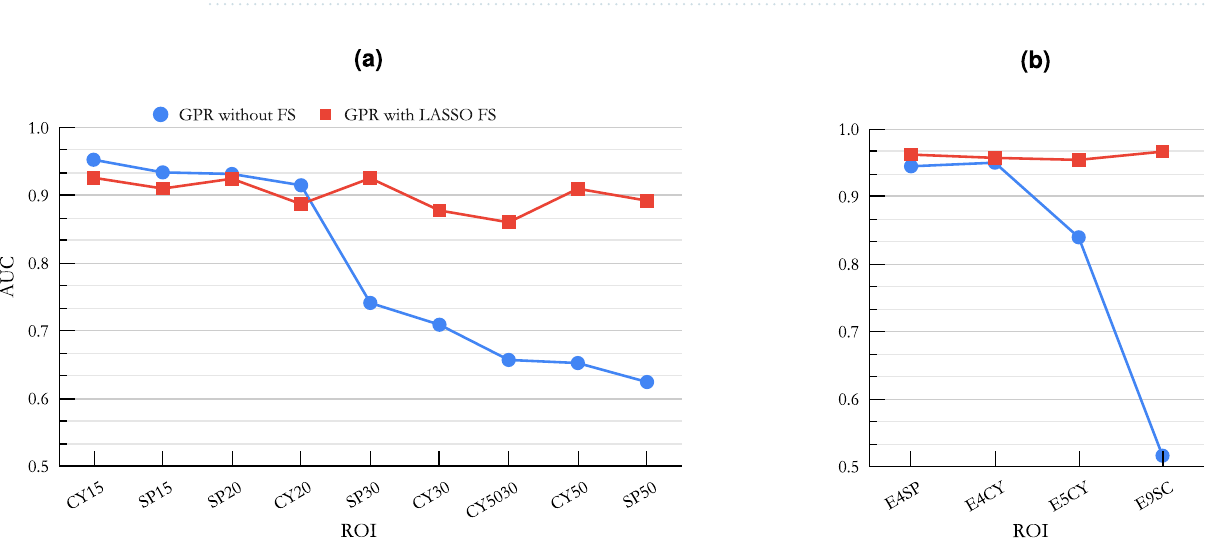
Figure 7. An example of AUCs versus the volume of the ROI for ( a ) single geometric ROIs and ( b ) for ensemble ROIs (Ref. Table 3). For this graph, we used our best performing ML classifier (GPR), with our best performing FS method (LASSO), and without FS